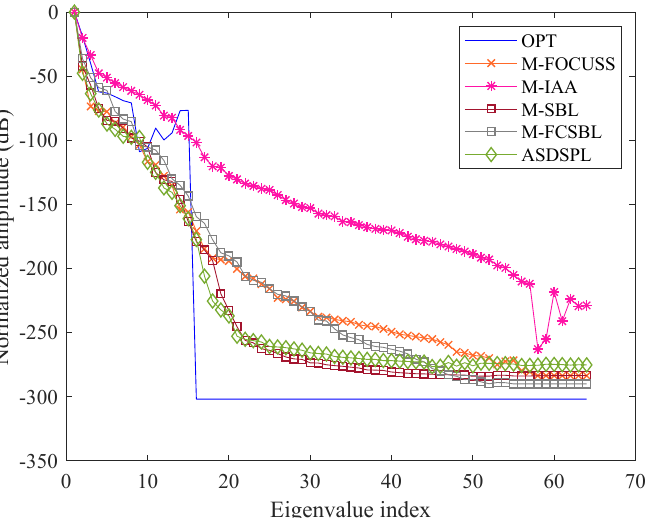
Figure 9. Eigen-spectra of the optimum CNCM and the estimated CNCM with the presence of GP error.